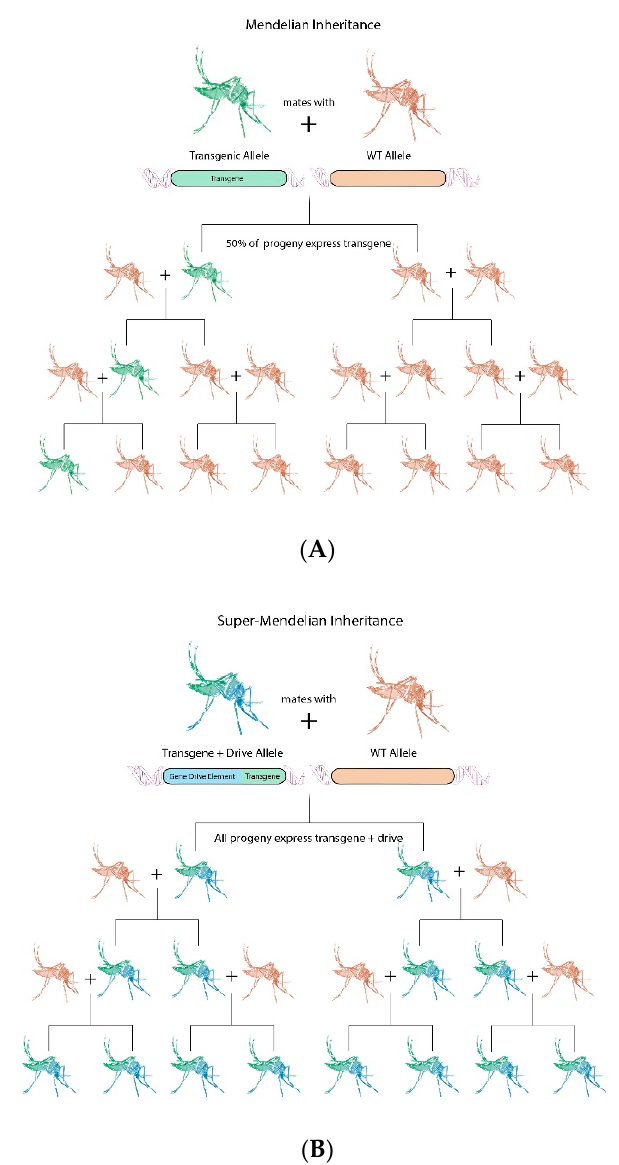
Figure 1. Mendelian versus “Super” Mendelian inheritance. ( A ) Mendel’s law of independent assortment predicts an inheritance rate of 50% for a transgene when it is not sex-linked. Without repeated introduction, loss of the transgene is expected because of multiple factors including genetic drift and fitness cost of the transgene. ( B ) Homing endonuclease based gene drives supersede Mendel’s law of independent assortment by converting wild-type alleles into gene drive bearing alleles in the germline. This then leads to fixation of the gene drive in the target population. SGEs can be genetically linked to exogenous genes-of-interest (g.o.i.) such as antiviral effectors